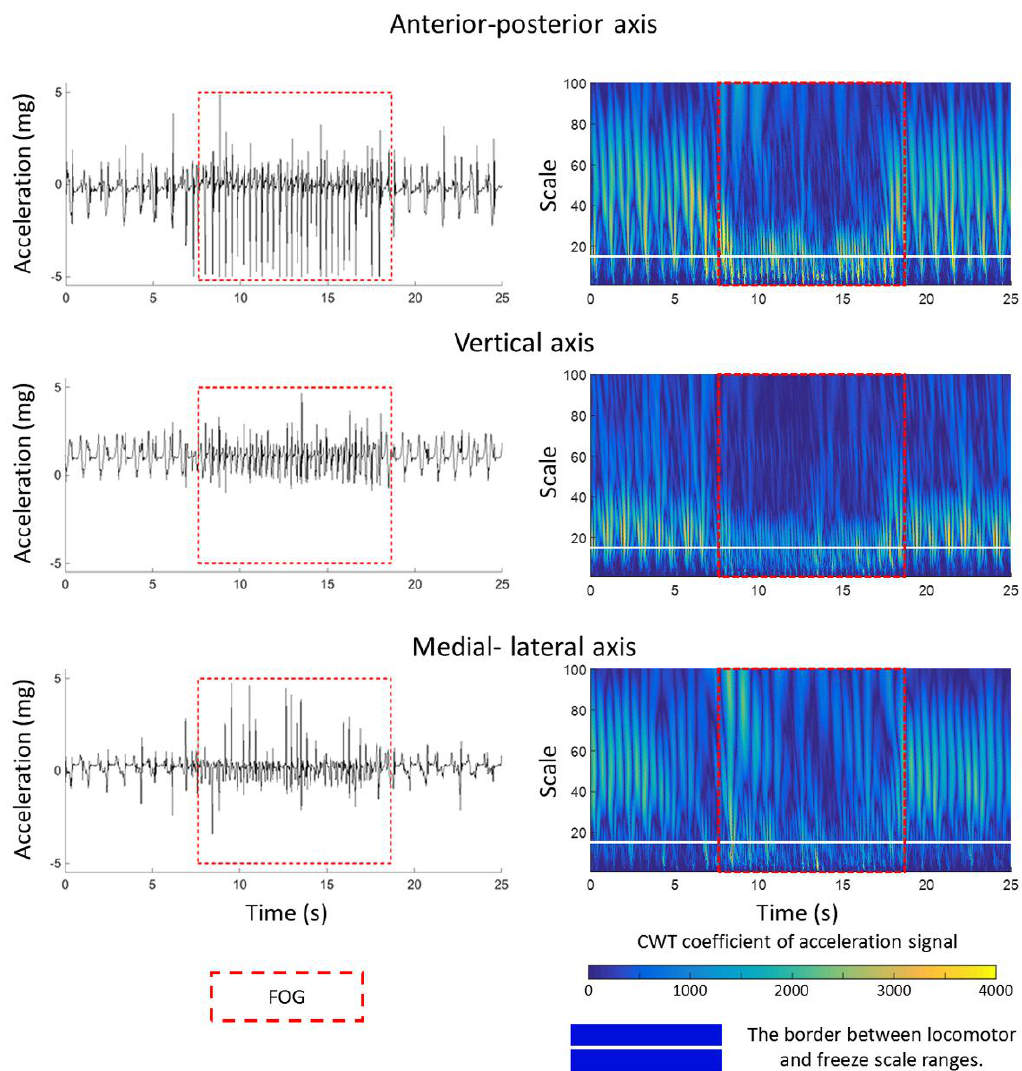
Figure 1. Shank acceleration signal and corresponding continuous wavelet transform of 25 s signal extracted from subject 2. The red dash rectangles denoted the true freezing of gait (FOG) episode period which physiotherapists identified by watching the video of a patient during the trials. At each continuous wavelet transform (CWT) plot, the white horizontal dash line indicated scale 15.2 which corresponded to 3 Hz and defined the border between locomotor and freeze scale ranges. The upper and lower sides of the white line indicated the locomotor and freeze scale ranges which corresponded to frequency ranges of 0.5–3 Hz and 3–8 Hz, respectively. The frequencies of 0.5, 3, and 8 correspond to the scales of 91.4, 15.2, and 5.7, respectively. Milli-gravitational acceleration is denoted by mg (980.665 mm/s 2 ).